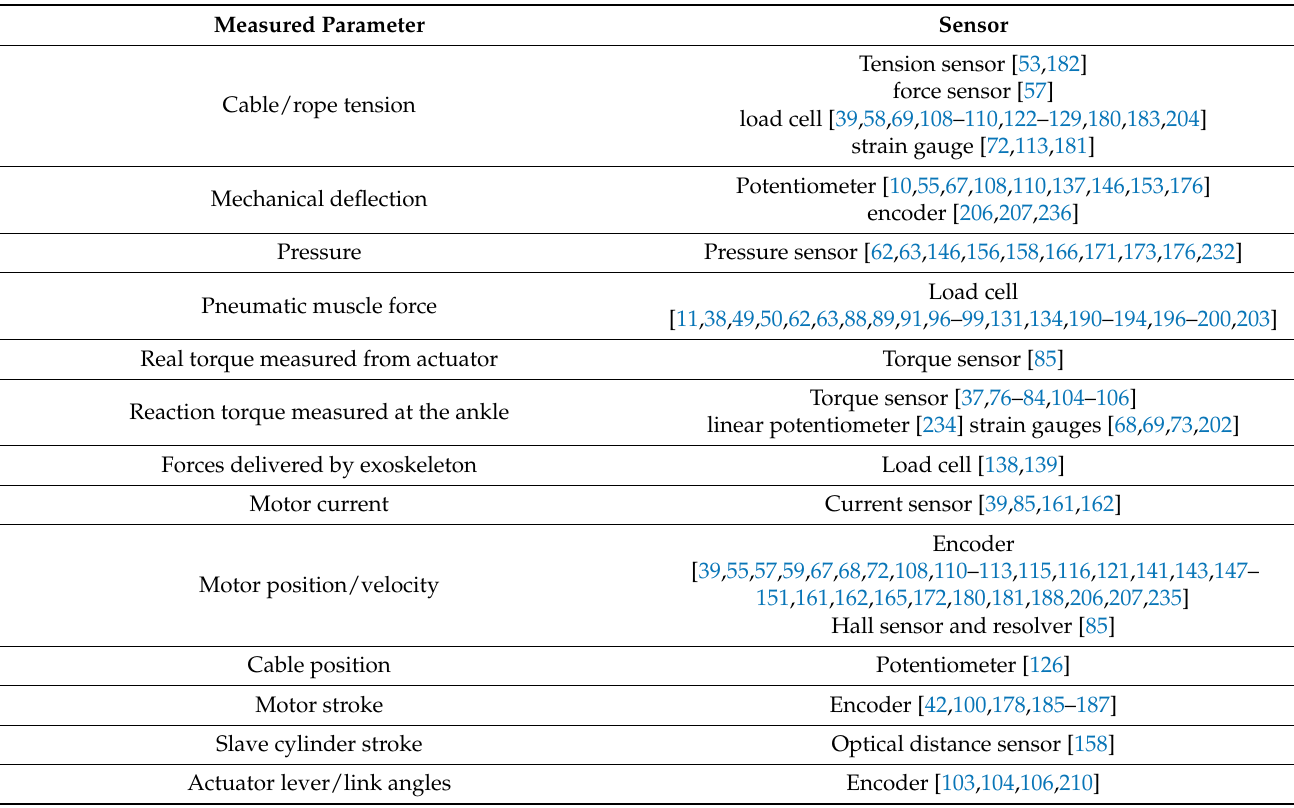
Table 7. Parameters measured by machine–machine interface sensors deployed in PAEs as reported by the reviewed articles. Different sensor types employed for measuring each parameter and their corresponding references are provided in the second